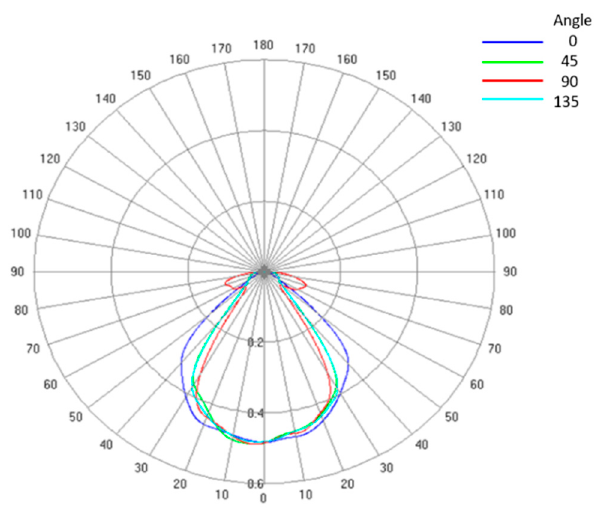
Figure 13. Intensity distribution curve for the beveled reflection surface.